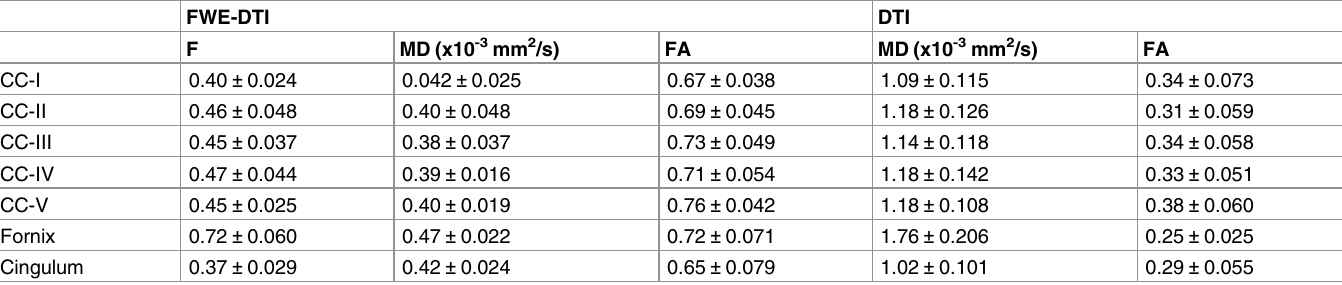
Table 3. Diffusion metricsof tracts. All values are listed as mean ±